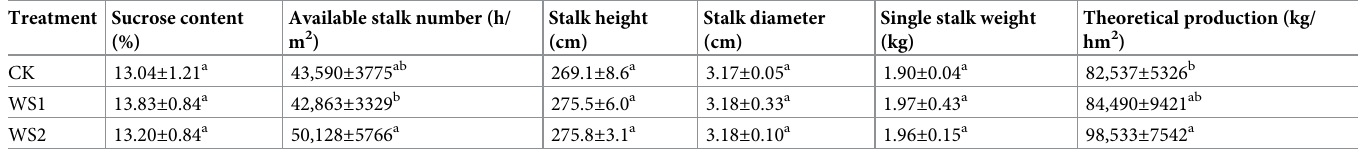
Table 1. Impact of water-soluble application on sucrose content, growth parameters, and yield of sugarcane. Treatment Sucrose content (%)